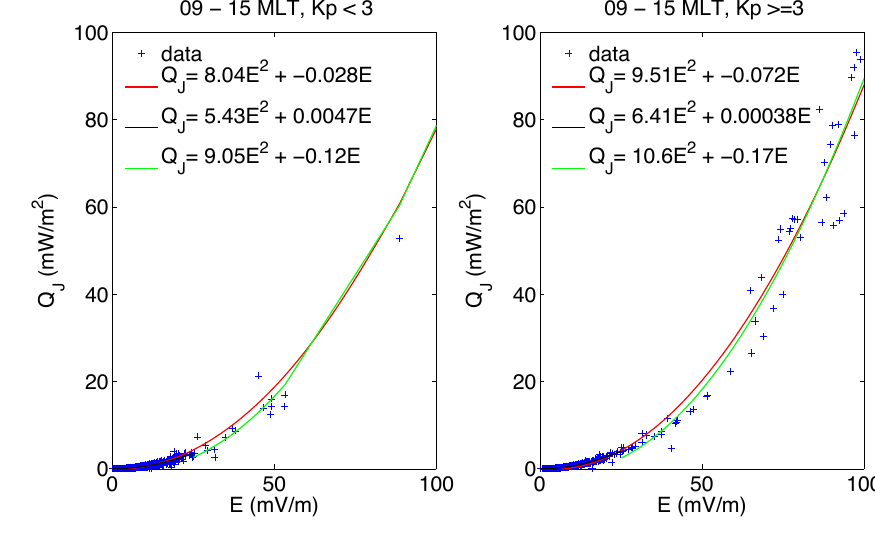
Fig. 14. Joule heating rate vs. total electric field in the midday sector for low ( K p =0–2, left) and high ( K p ≥ 3, right) activity levels. Three fits to data (+) are shown: the red curve for all data (first equation in the legend), the black curve to low electric fields (second eq.) and the green curve (third eq.) for high electric fields with the limit as 25mVm − 1 .